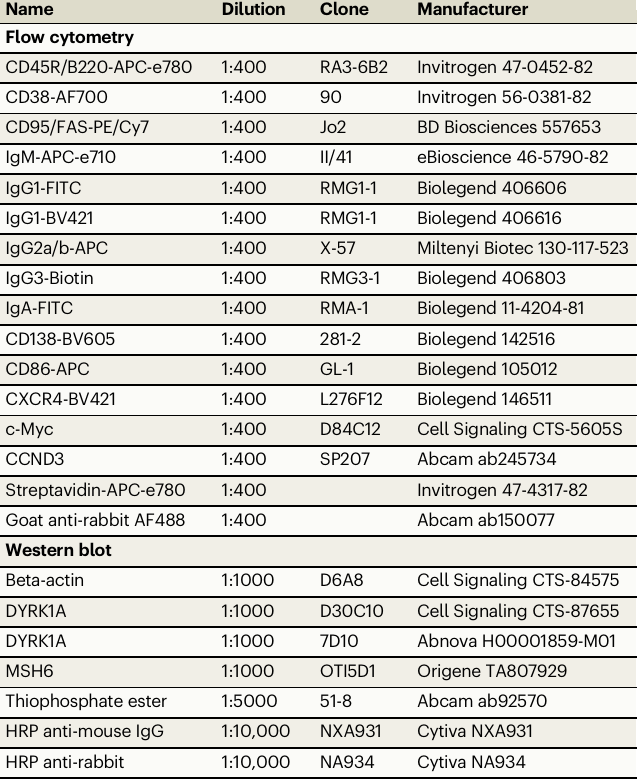
Table 1 | Antibodies used in fl ow cytometry and western